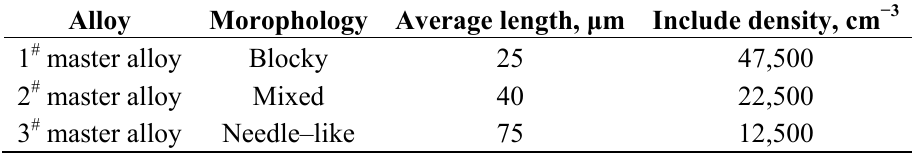
particles in Al–5Ti master alloys. 3